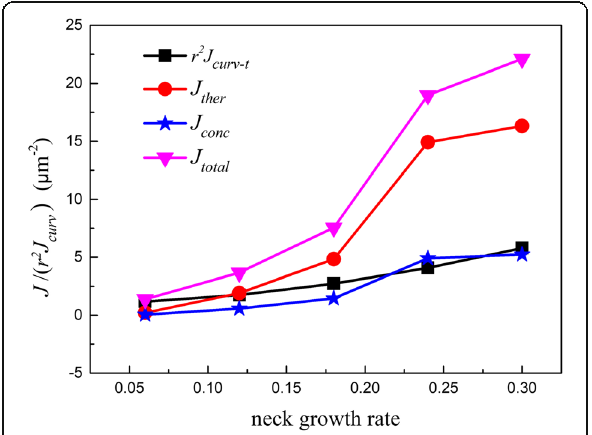
Fig. 6 Comparison of the ratio of diffusion flux under volume